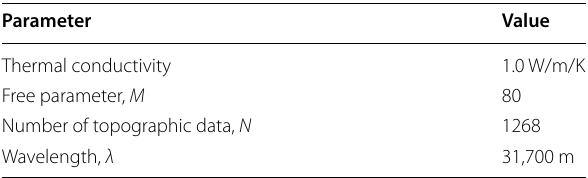
Table 2 Parameters used for thermal modeling in the A–B cross section southwest of the Kii Peninsula